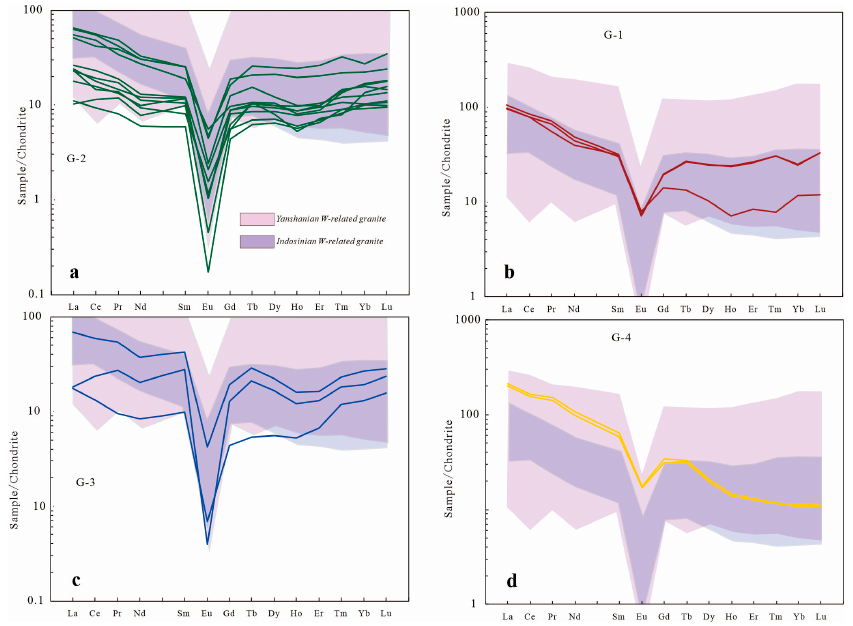
Figure 10. Chondrite-normalized REE patterns of granitoids in Chuankou ore field (Standardized values from [48]). ( a ) G-2; ( b ) G-1; ( c ) G-3, ( d ) G-4.